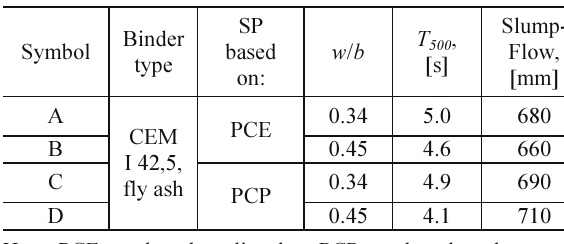
Table 5. Concrete air void parameters investigated according to EN 480-11 (Gorzelańczyk 2007) Porosity structure parameter